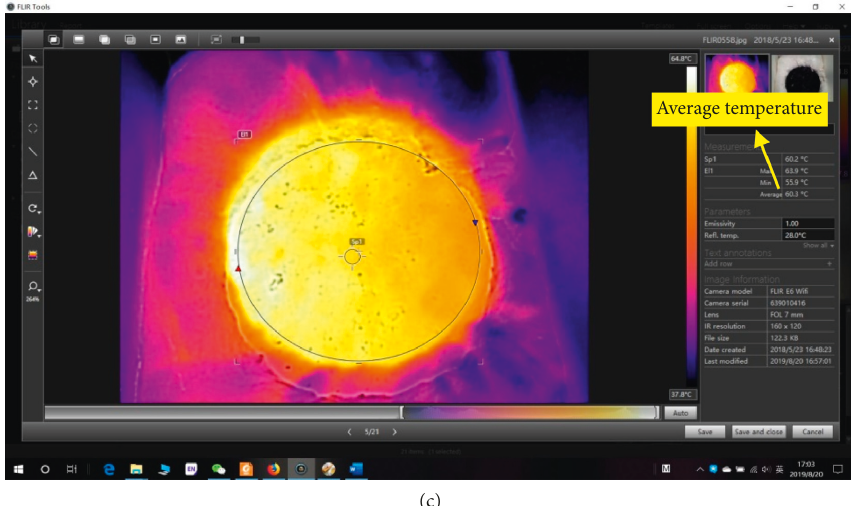
Figure 6: Infrared images of the control mixture specimen: (a) at the beginning of irradiation; (b) at the end of irradiation; (c) the processing interface of the recorded temperature data.